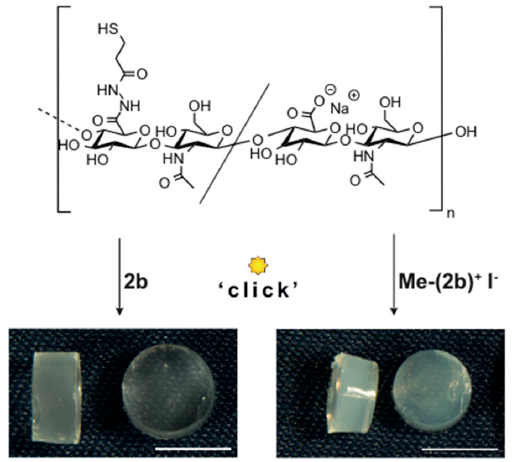
Figure 2. Form-stable, semi-opaque hydrogels can be obtained with, e.g., bismaleimidotriazole cross-linker 2b and Me-(2b) + I − and statistically thiolated hyaluronan. Here, we employ hyaluronan with an average weight of 125 kDa (HA 125 -SH 40 ), corresponding to an average number of 330 disaccharide monomers. Scale bars represent 0.5 cm.